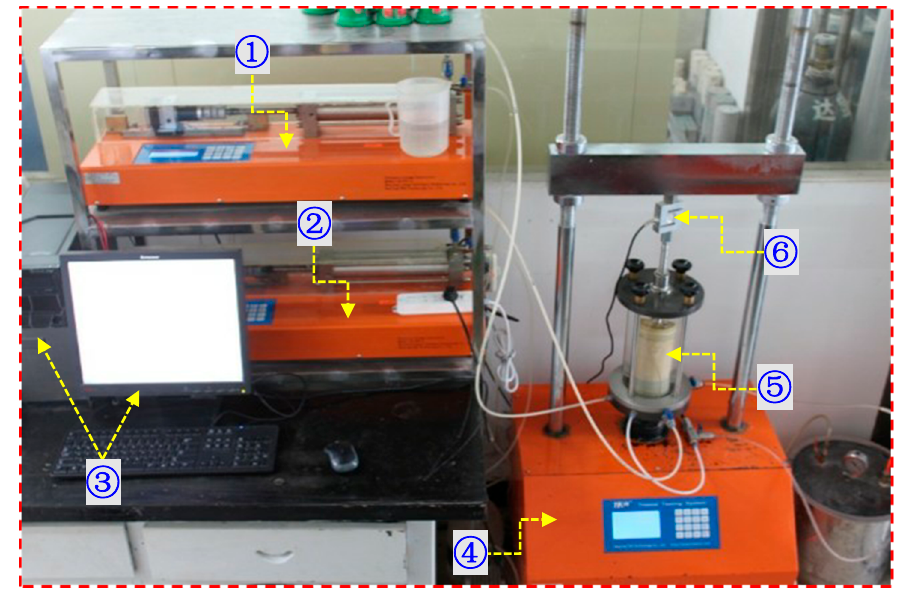
Figure 2. TKA-Advanced full-automatic stress path triaxial testing apparatus. ① —Back pressure control system; ② —confining pressure control system; ③ —data acquisition system; ④ —strain control system; ⑤ —pressure chamber; ⑥ —axial load sensor.